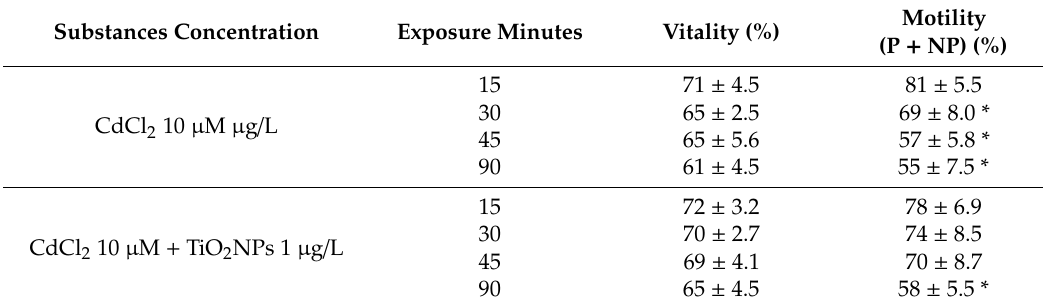
Table 3. Sperm vitality and motility after CdCl 2 exposure and TiO 2 NPs co-exposure. The values were expressed as mean ± SD. * p ≤ 0.01.